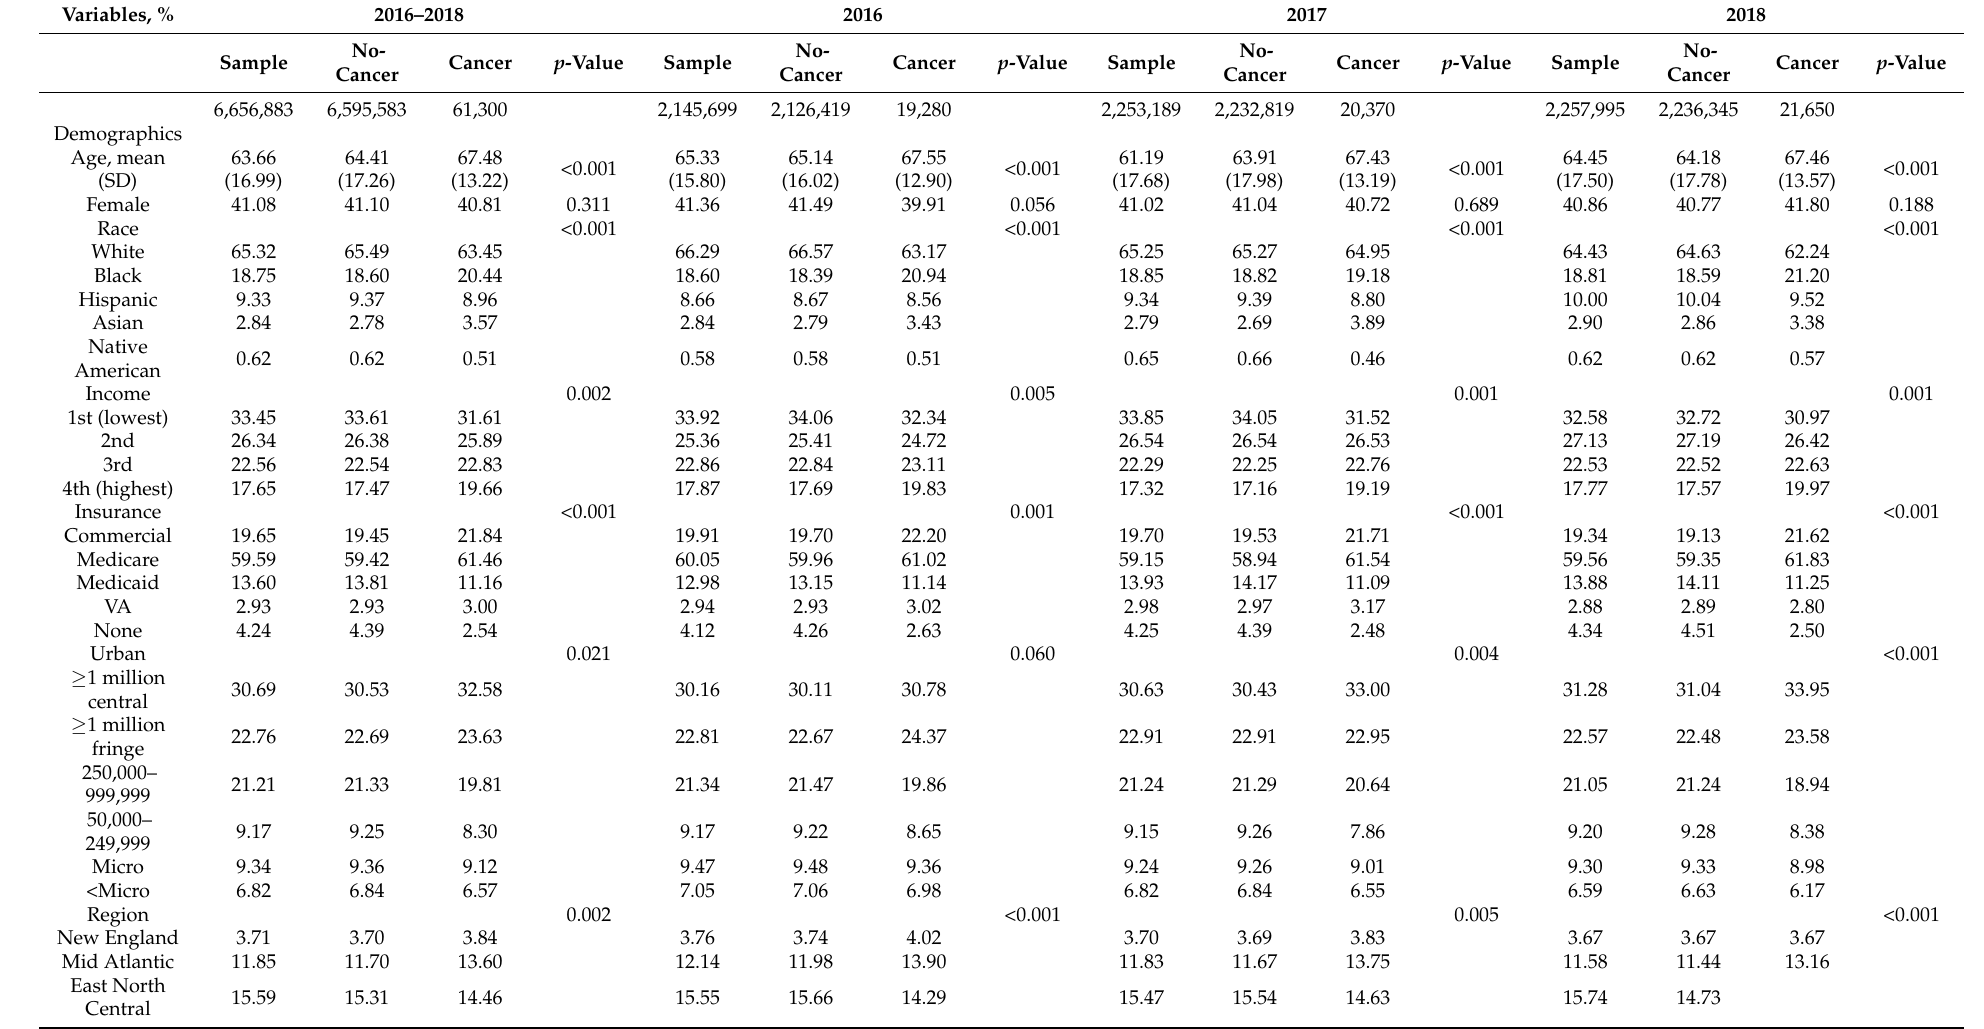
Table 1. Descriptive and bivariable analysis by active cancer in cardiac arrest by year ( N =